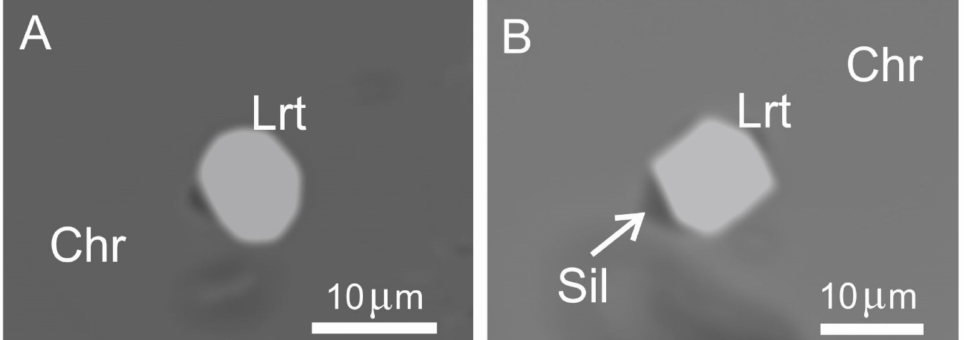
Figure 9. BSE images of polygonal laurite enclosed in chromite of the high-Cr chromitites of Sebuku Island. Single phase crystals ( A ), and in contact with silicate, possible pyroxene ( B ). Abbreviations: Chr—chromite, Lrt—laurite,